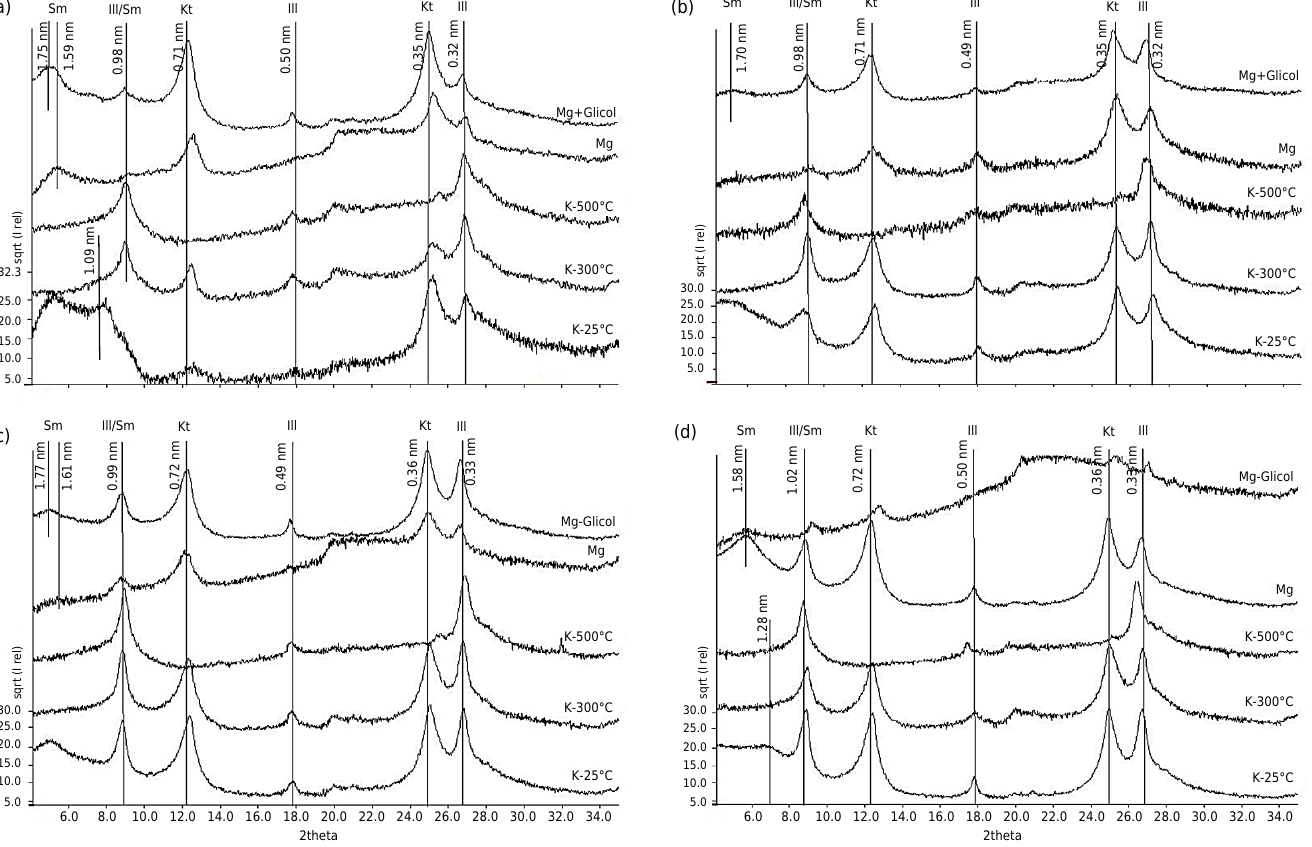
Figure 2. X-ray diffractograms of clay fraction in the horizons or layers in the soil profiles located in the lower course of the Acaraú River (Ceará State, Brazil). (a) horizon 3Cvn (Fluvisol); (b) horizon 2Btvnz (Planosol); (c) horizon Cvn (Vertisol); (d) Horizon Cgnz2 (Solonchak). Sm: smectite; Ill: illite; Kt: